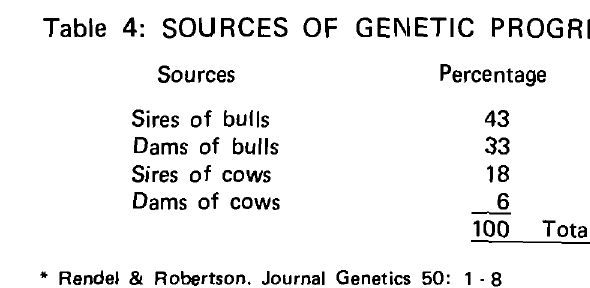
Table 4: SOURCES OF GENETIC PROGRESS'"